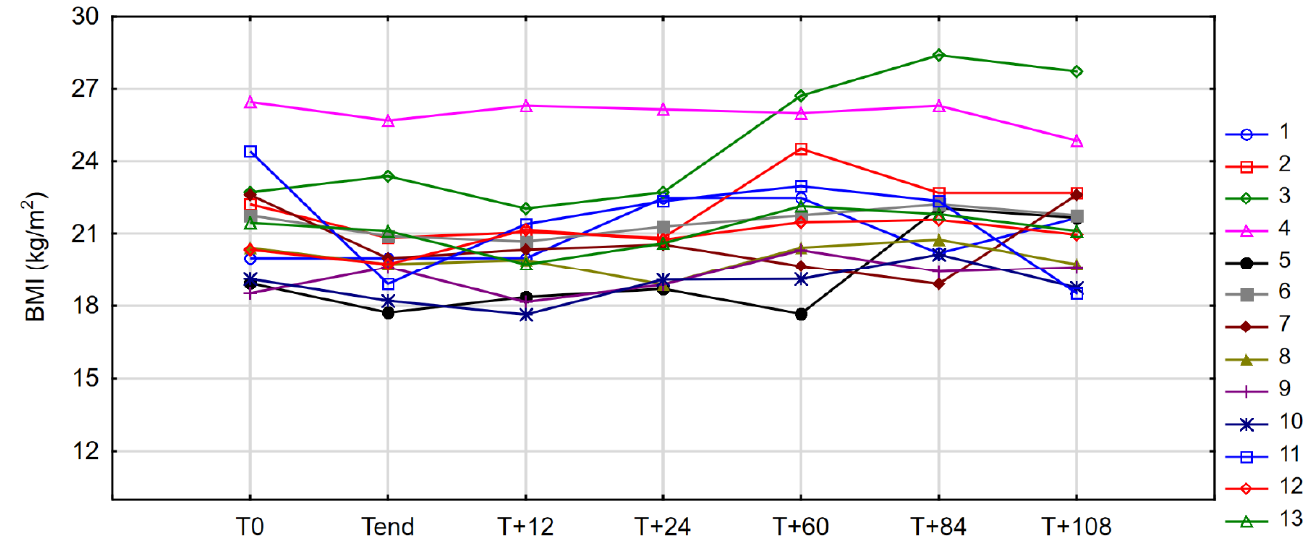
Figure 3. Changes in body mass index (BMI) in individual patients between observation time points (case profiles).